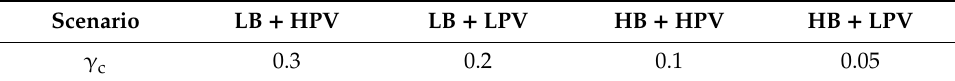
Table 2. Battery charge e ffi ciency degradation factor: γ c